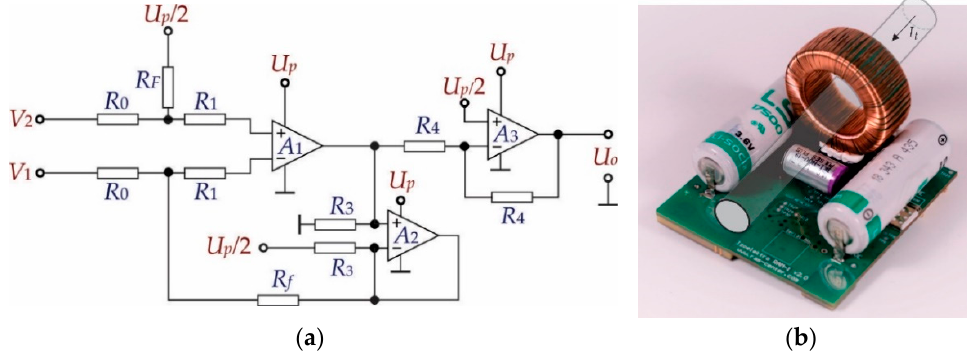
Figure 9. ( a ) Analogue signal acquisition circuit; ( b ) PCB (printed circuit board) with components of the measurement device.